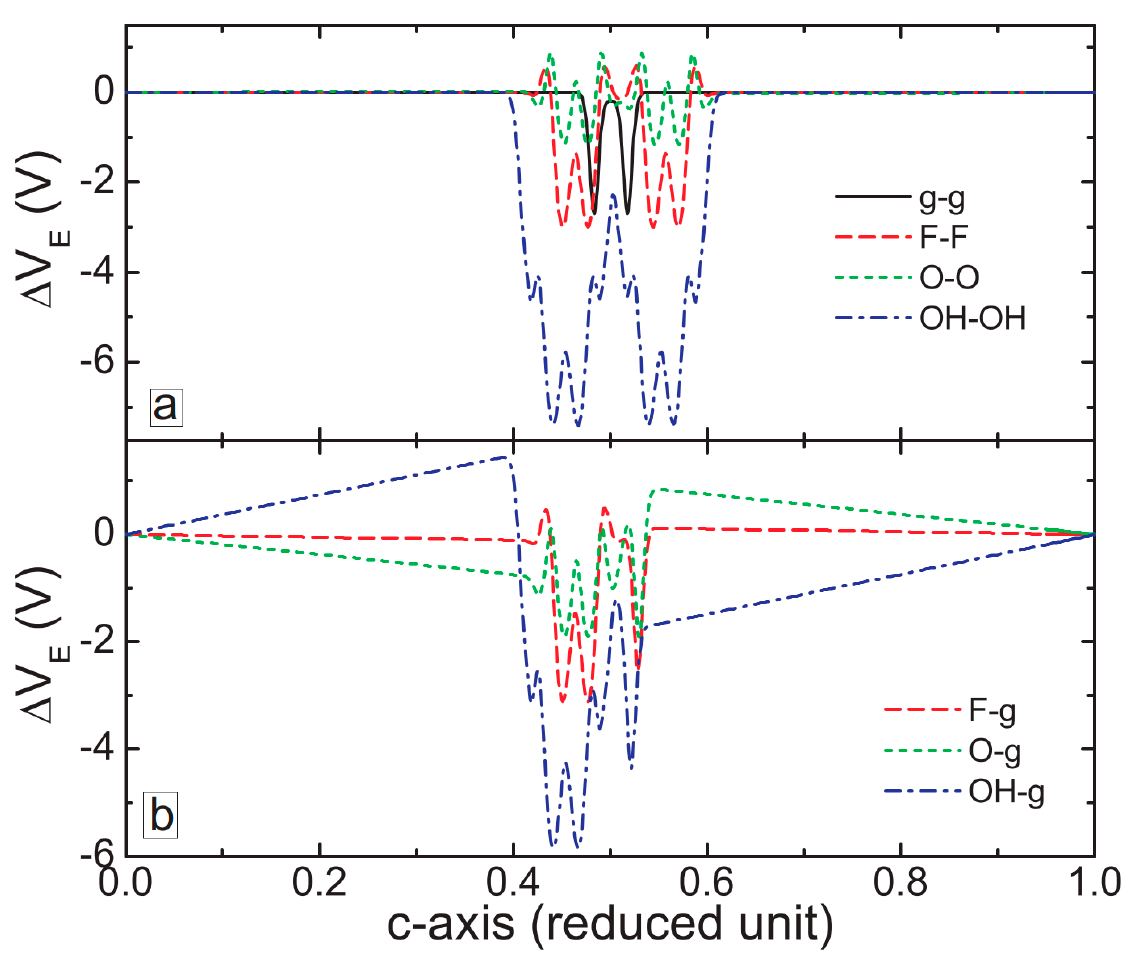
Figure 3. Electrostatic potential variations across the layers of graphene/graphene, MXene/MXene ( a ), and MXene/graphene bilayer samples ( b ).